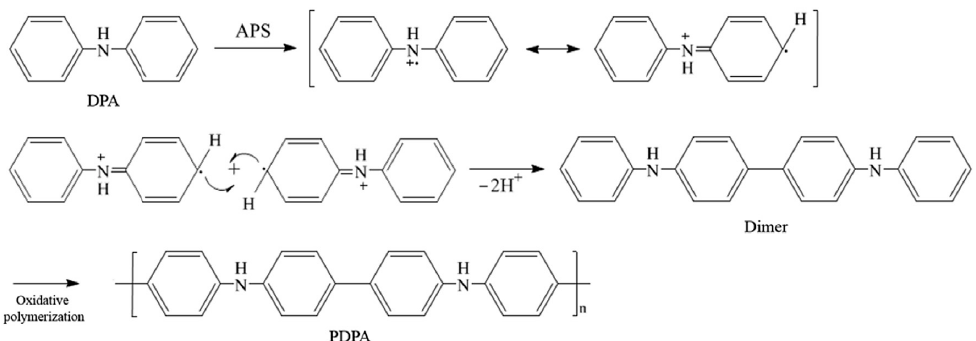
Figure 6. SEM images of ( a ) Poly(diphenylamine) (PDPA), reprinted with permission from [70].